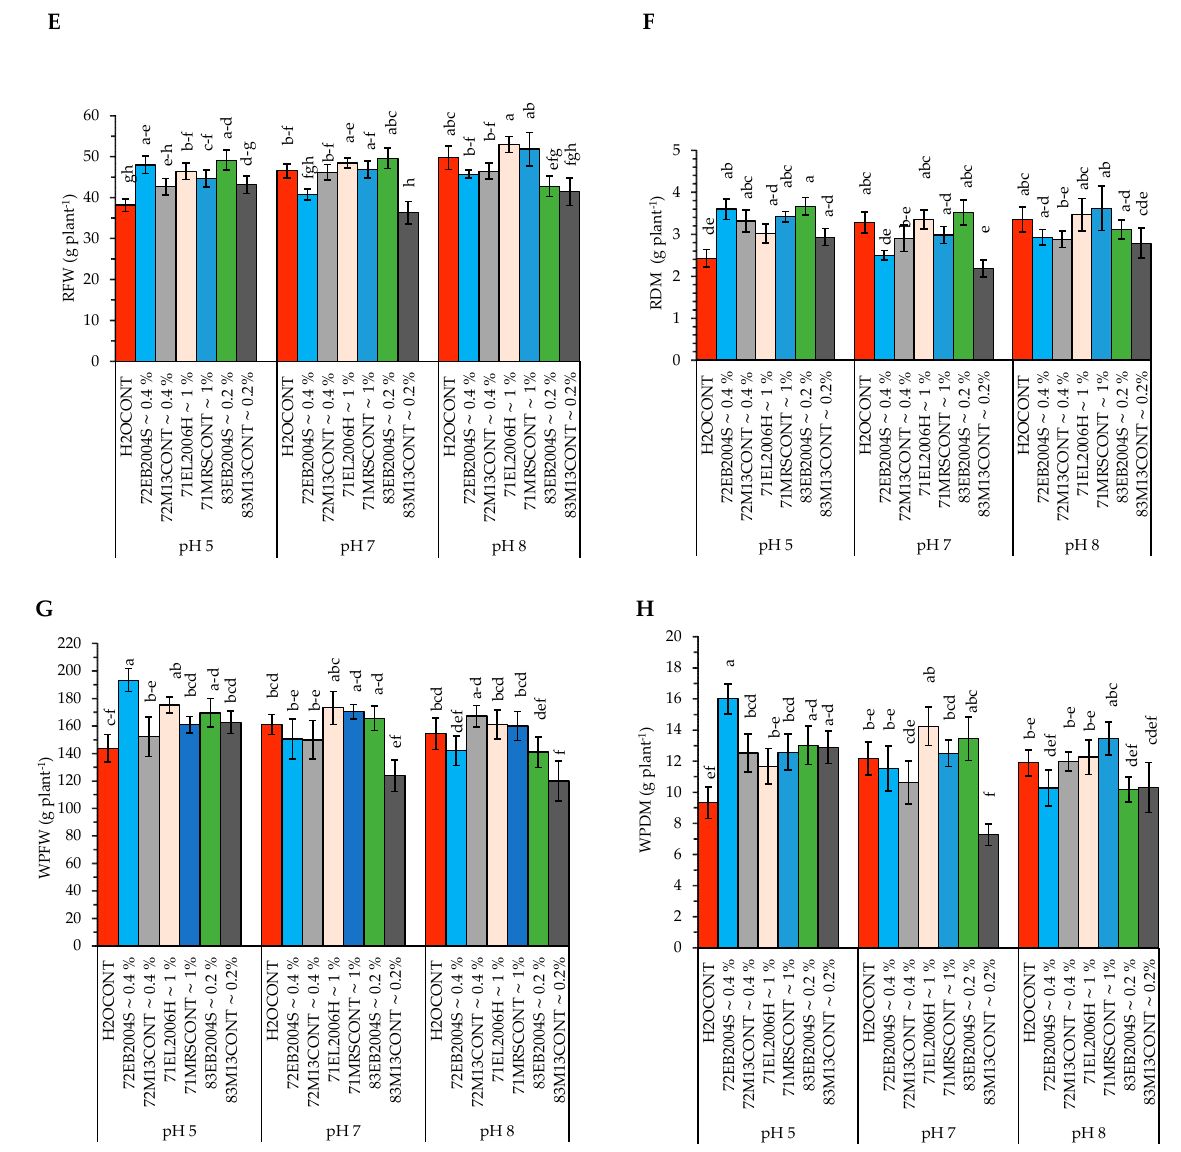
Figure 2. The interaction effect of pH and CFS treatments obtained from the cultured L. helveticus and B. subtilis (Experiment 2) at pHs 7 and 8 on potato; ( A ) plant height; ( B ) leaf greenness measured in SPAD units; ( C ) leaf area; ( D ) shoot dry matter (SDM*); ( E ) root fresh weight (RFW*); ( F ) root dry matter (RDM*); ( G ) whole plant fresh weight (WPFW); and ( H ) whole plant dry matter (WPDM*) under greenhouse conditions. Values are expressed in their respective units and means, dissimilar letters indicate significant ( p = 0.05, LSD) difference among treatments. Error bars represent standard error of means (SEM).